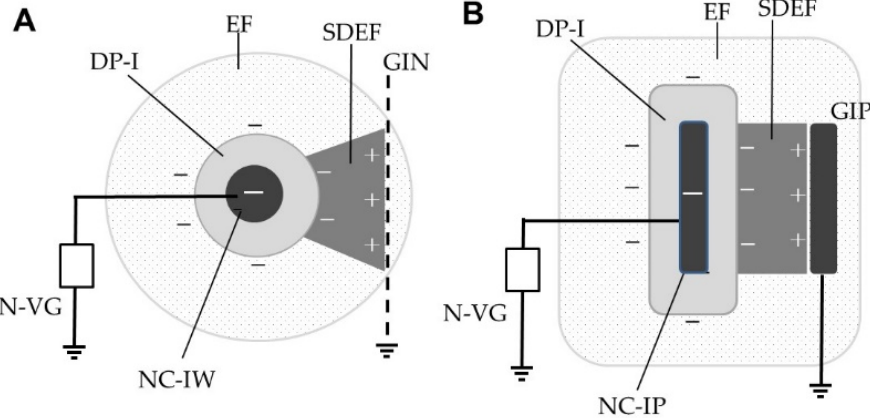
Figure 1. Single-charged dipolar electric field (SDEF) produced within an EF produced by a negatively charged insulated conductor (NC-IC) by opposing a charged insulated iron wire to a grounded metal net ( A ) or a charged insulated iron plate to a grounded non-insulated iron plate ( B ). N-VG, negative voltage generator; DP-I, dielectrically polarized insulator with negative charge on its surface; EF, electric field; NC-IW, negatively charged iron wire; NC-IP, negatively charged iron plate; GIN, grounded iron net; GIP, grounded iron non-insulated plate [5].